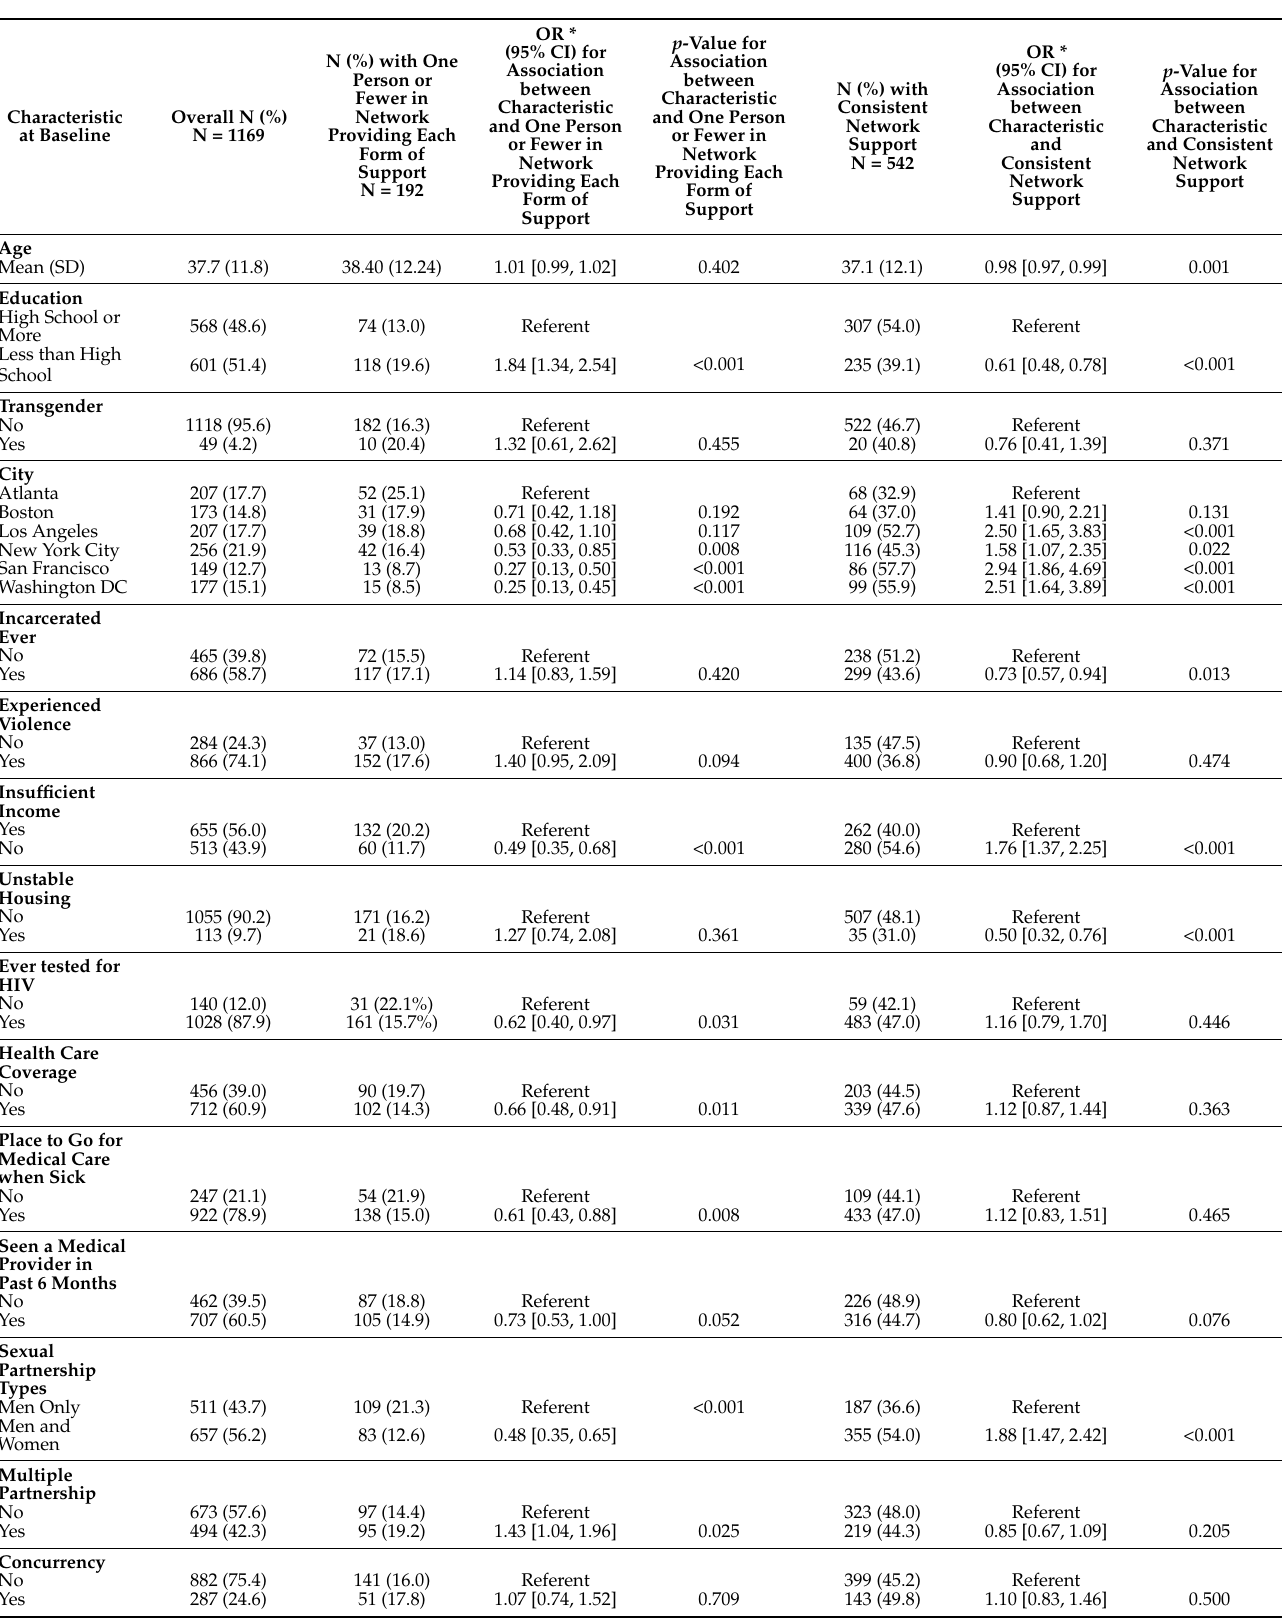
Table 1. Baseline Characteristics of HPTN 061 Sample and Associations with Network Size and Types at 12 Months (N =